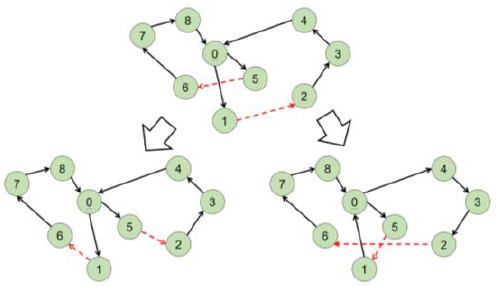
Figure 3. 2-opt Swap Method Concept (b).